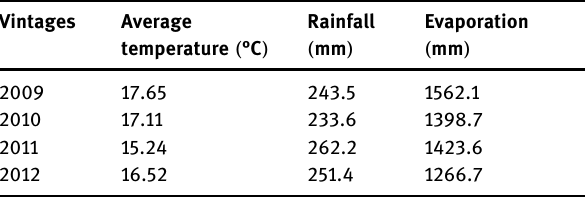
Table 1: Climate information of the vineyard during the